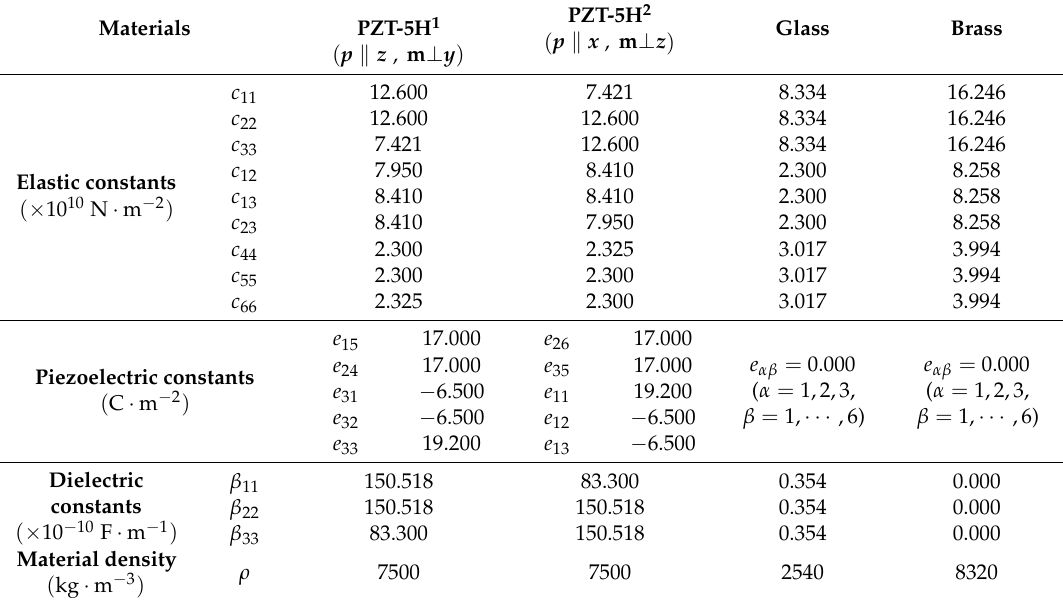
Table 3. Material parameters of the constituent layers in unit cell.